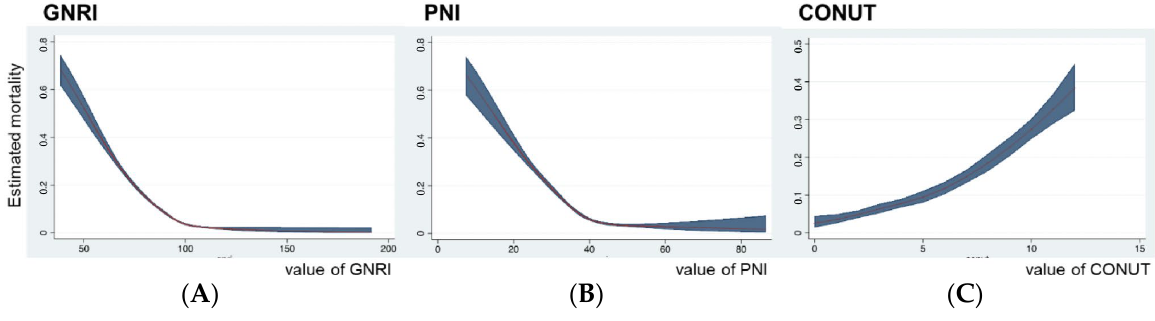
Figure 2. Non-linear cubic spline curve of nutrition indices against mortality in sepsis. ( A ), GNRI (Geriatric Nutritional Risk Index). ( B ), PNI (Prognostic Nutritional Index). ( C ), CONUT (Controlling Nutrition Status).